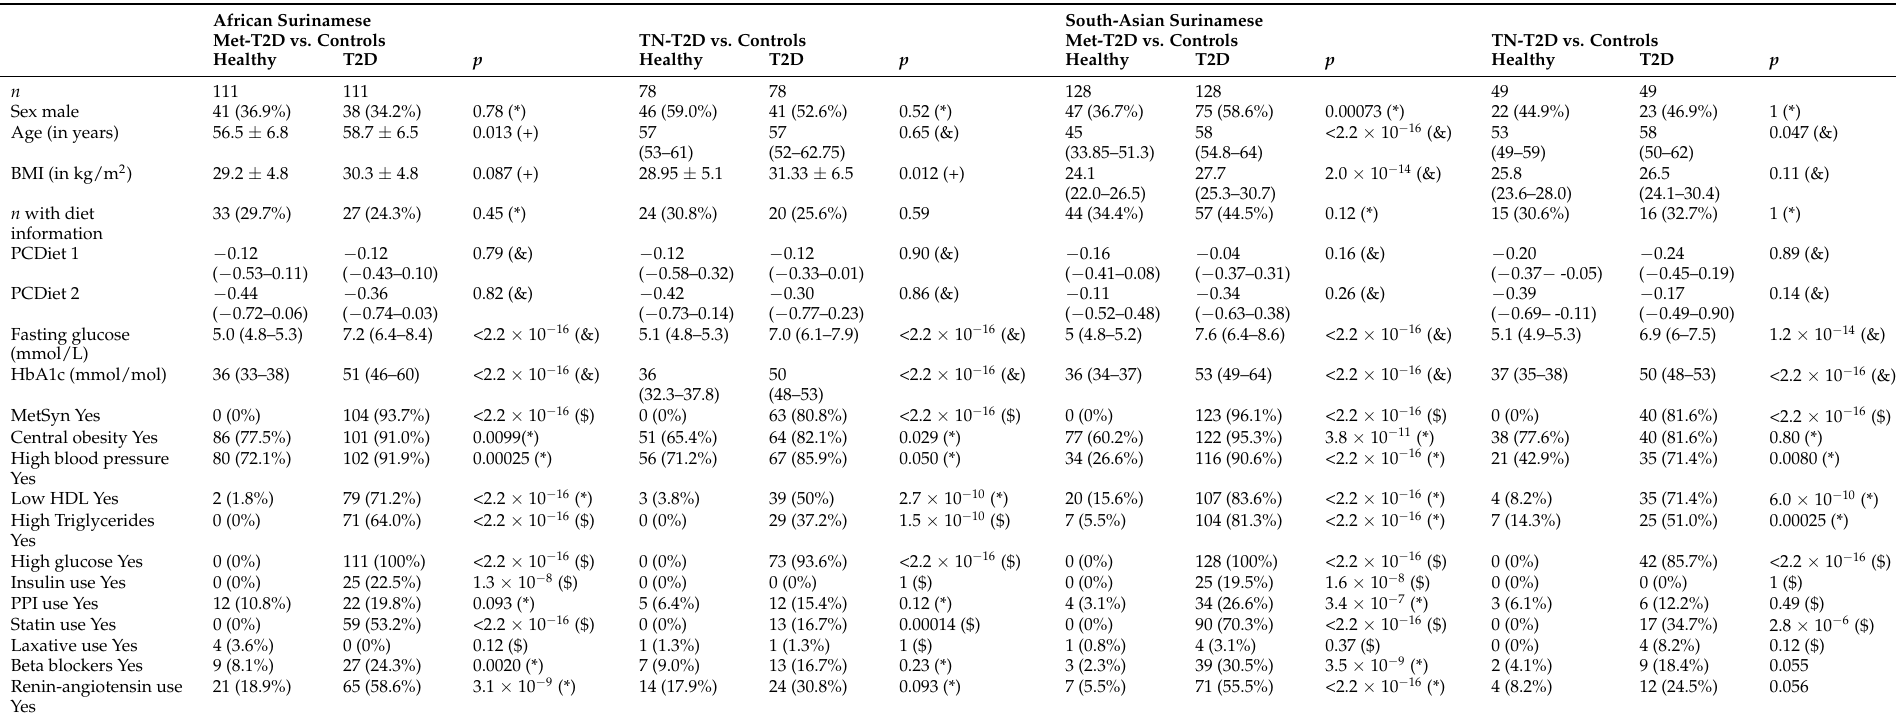
Table 1. Population characteristics. Overview of population characteristics for African Surinamese and South-Asian Surinamese for both metformin treated (Met-T2D) and treatment-naïve (TN-T2D) diabetes subjects and their matched